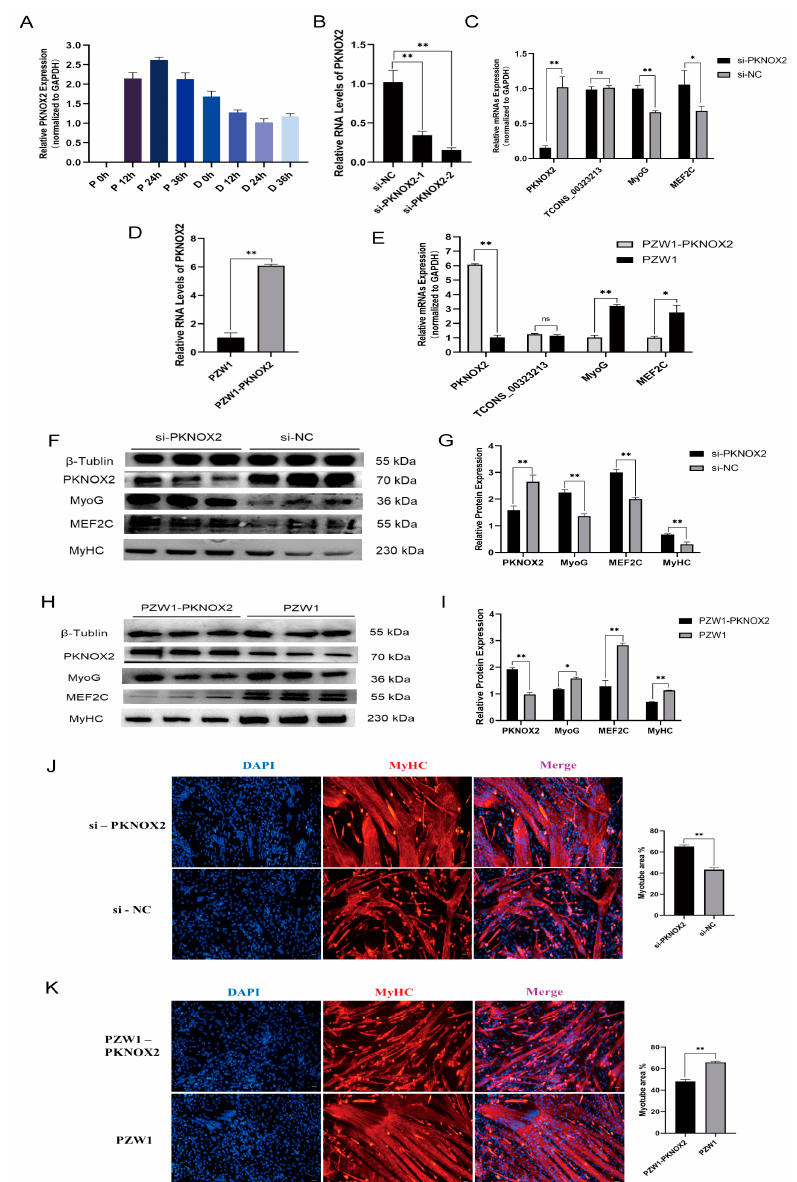
Figure 4. Role of PKNOX2 in the differentiation of PSCs. ( A ) Real-time PCR analysis of PKNOX2 expression in PSCs during the period of proliferation and differentiation. There was a 12 h interval between each period. ( B ) A screening assay of siRNAs targeting PKNOX2 showed that si- PKNOX2-2 had the highest interference efficiency. ( C ) The knockdown of PKNOX2 increased the mRNA levels of MyoG and MEF2C . ( D ) Overexpression vector effect testing. ( E ) Overexpression of PKNOX2 decreased the mRNA levels of MyoG and MEF2C . ( F , G ) Knockdown of PKNOX2 increased the protein levels of MyoG, MEF2C , and MyHC . ( H , I ) Overexpression of PKNOX2 decreased MyoG, MEF2C, and MyHC protein expression levels. ( J ) IF in PSCs differentiated for 36 h, showing that the MyHC expression level was significantly increased by PKNOX2 knockdown. ( K ) IF in PSCs differentiated for 36 h showing that PKNOX2 overexpression significantly decreased the MyHC expression level. Mean values ± SD, n = 3. * p < 0.05, ** p < 0.01. ns indicates no significant